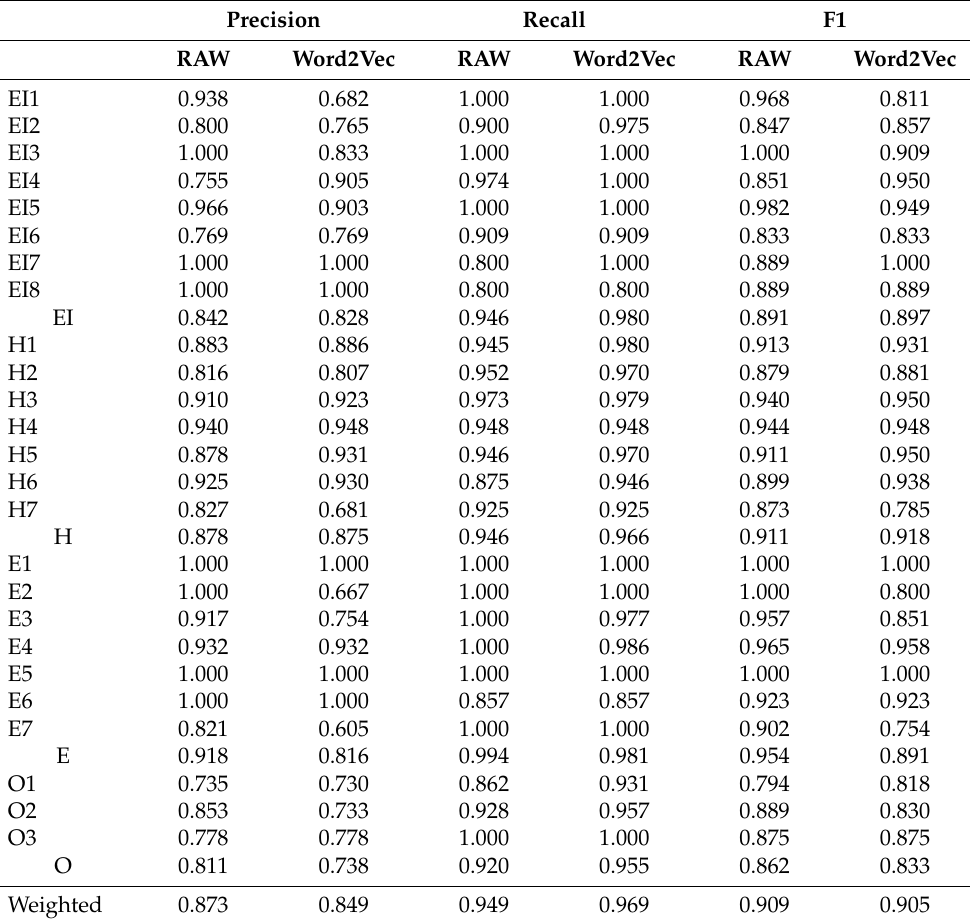
Table 10. Final results of cause